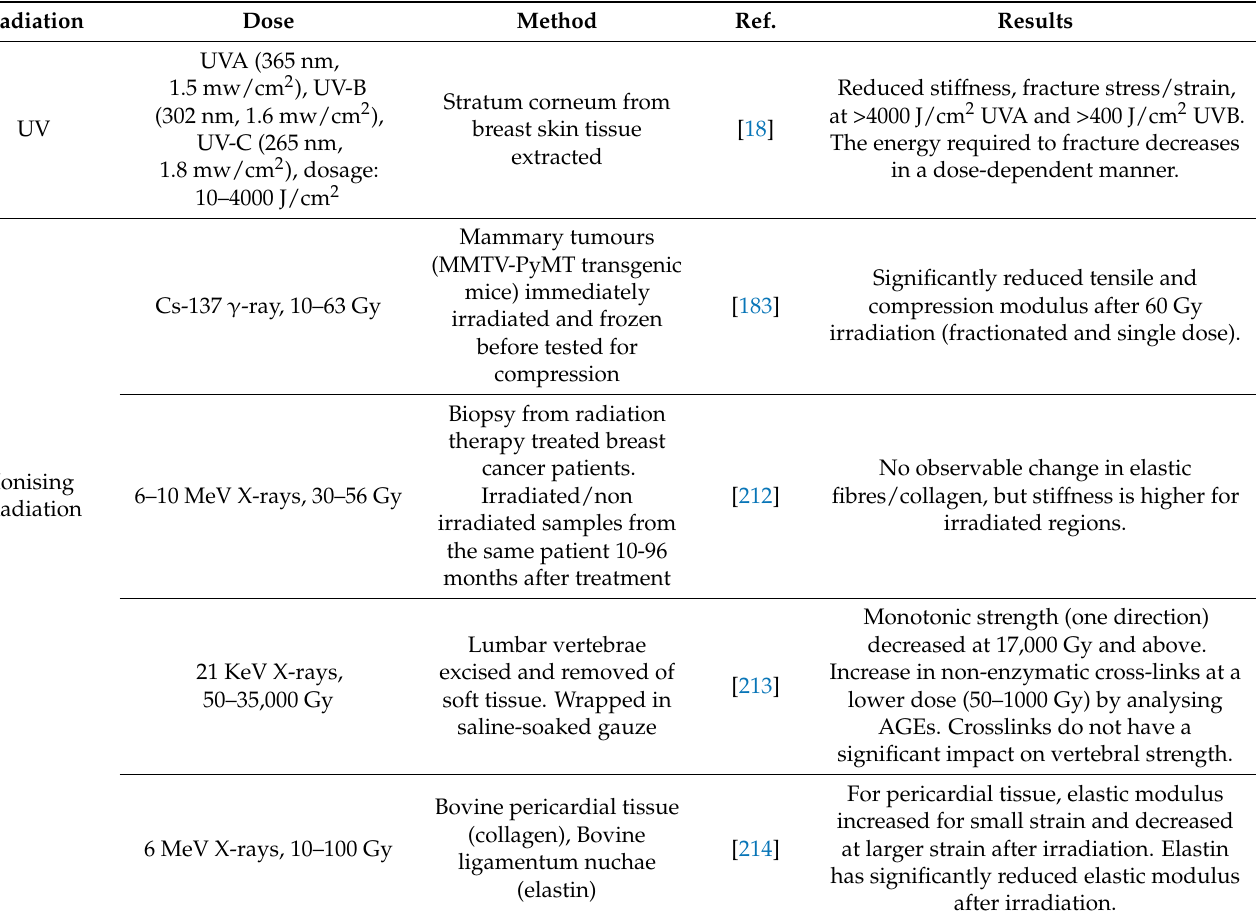
Table 4. Ex vivo experiments utilise complex model systems that give biologically relevant consequences of radiation effects. Studies show that radiotherapeutic doses of X-rays (around 50 Gy) can alter the mechanical properties of ex-vivo samples. Radiation Dose Method Ref.